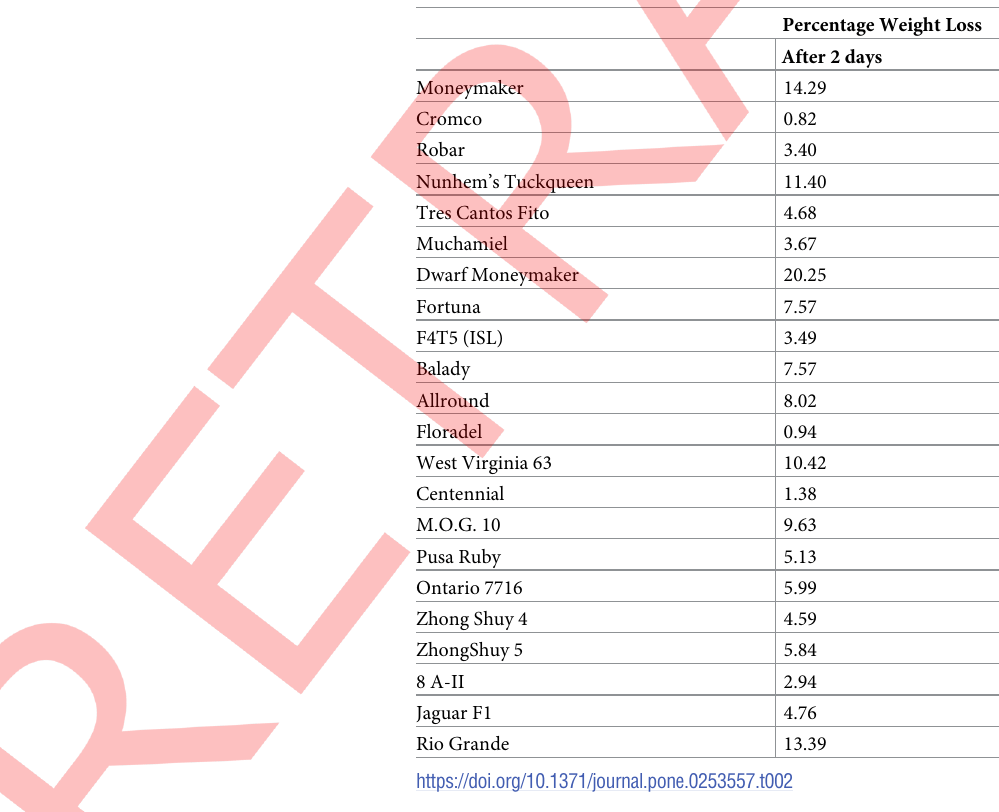
Table 2. Percentage weight loss measured after 2 days and 4 th day of